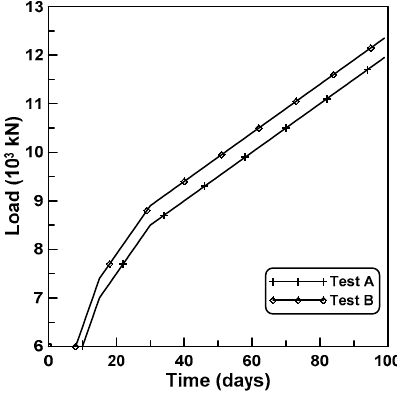
Figure 8. Two time-dependent load histories.